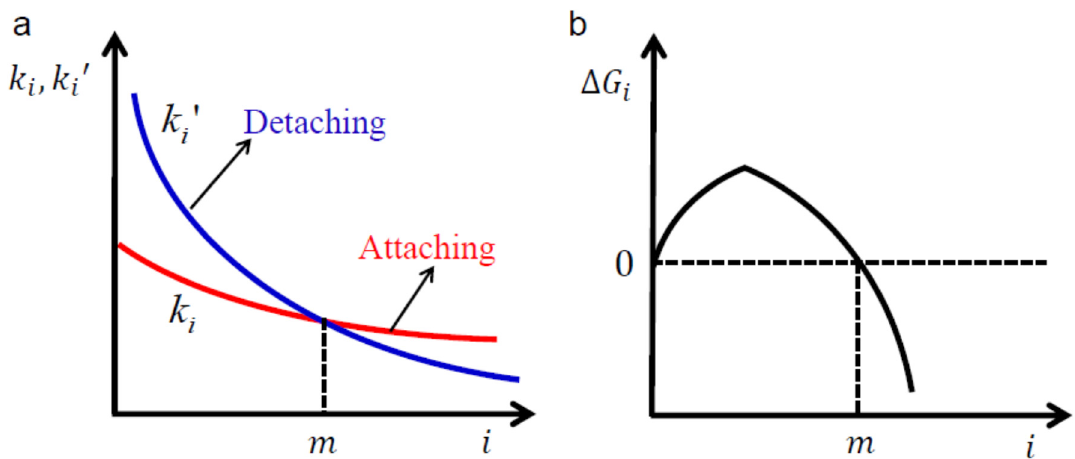
Figure 7. Microscopic kinetics of attaching and detaching for flexible polymer chains. ( a ) Variation of the rate constants of attaching and detaching with a number of monomers; ( b ) free energy change of formation of nuclei containing a different number of monomers. The symbol m indicates the number of monomers within the minimum stable nuclei for crystals of flexible polymers.